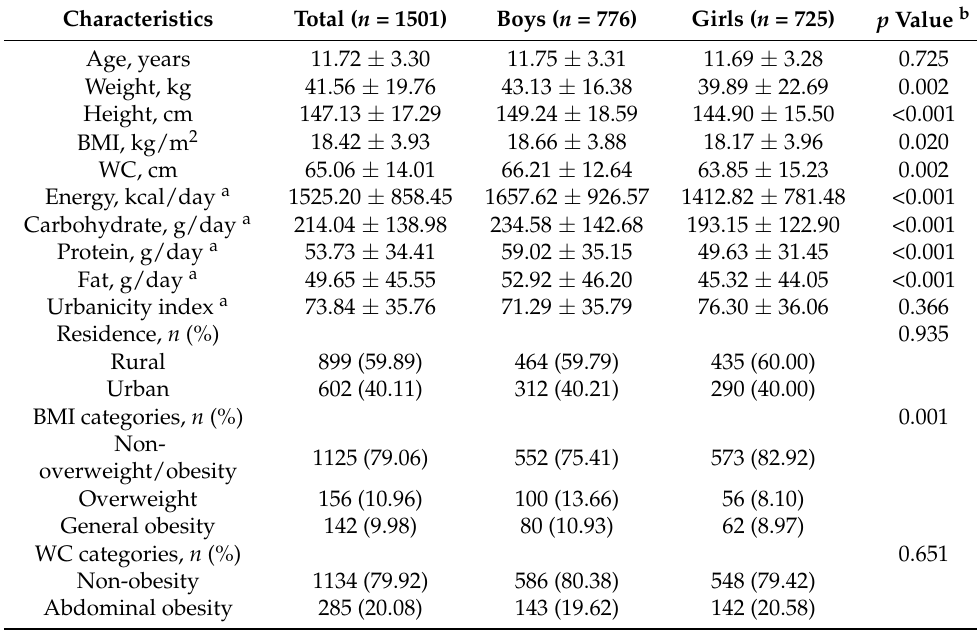
Table 1. Characteristics of participants by